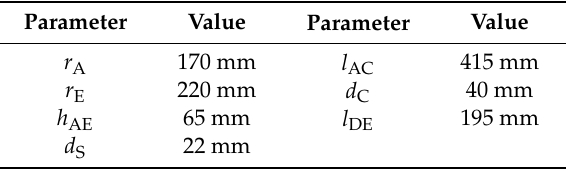
Table 1. Dimension parameters of the landing gear robot.